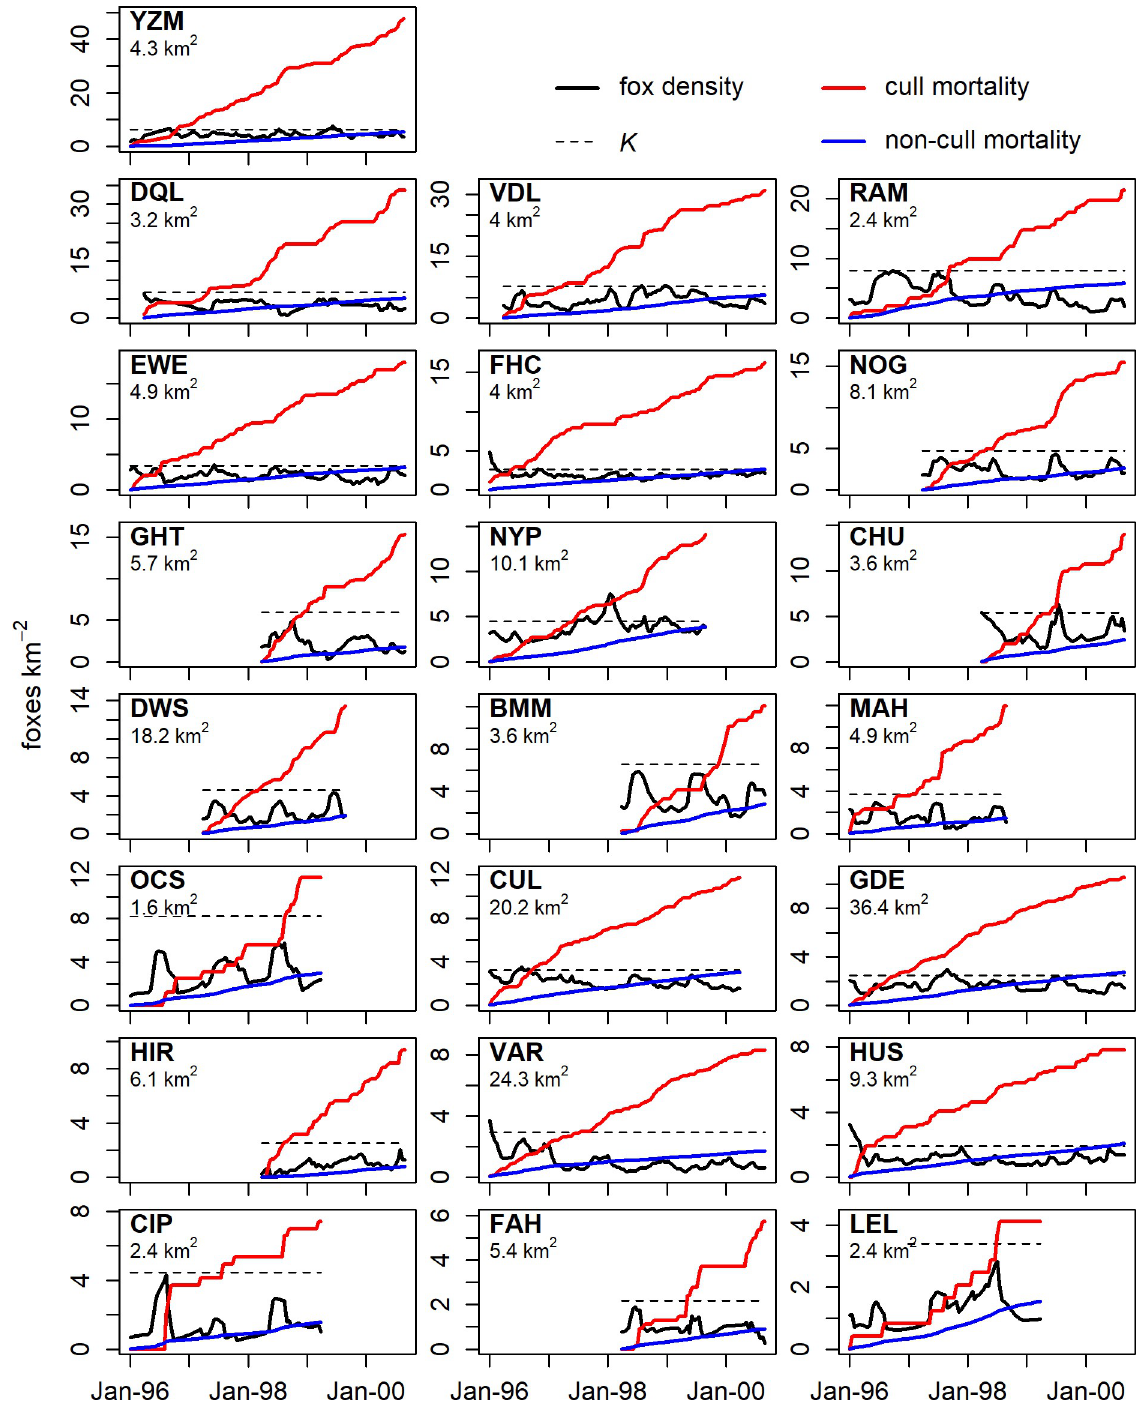
Fig 5. Comparison of the cumulative culling mortality and estimated cumulative non-culling mortality implied by the posterior median of M on each estate over the range of the contributed data. Posterior median fox density and carrying capacity of each estate are shown. The scale of mortality (shown in dead foxes km -2 ) differed so estates are ordered by row from top-left to bottom-right by decreasing total mortality. On most estates the cull dwarfed estimated non-culling mortality and exceeded estimated initial density within 6–12 months.